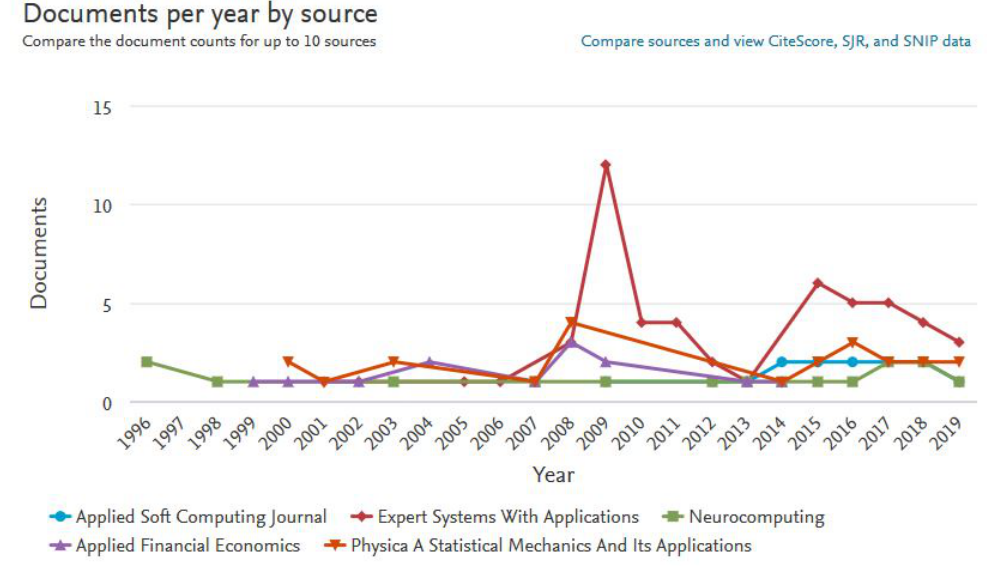
Fig. 3. Published research timeline (source: